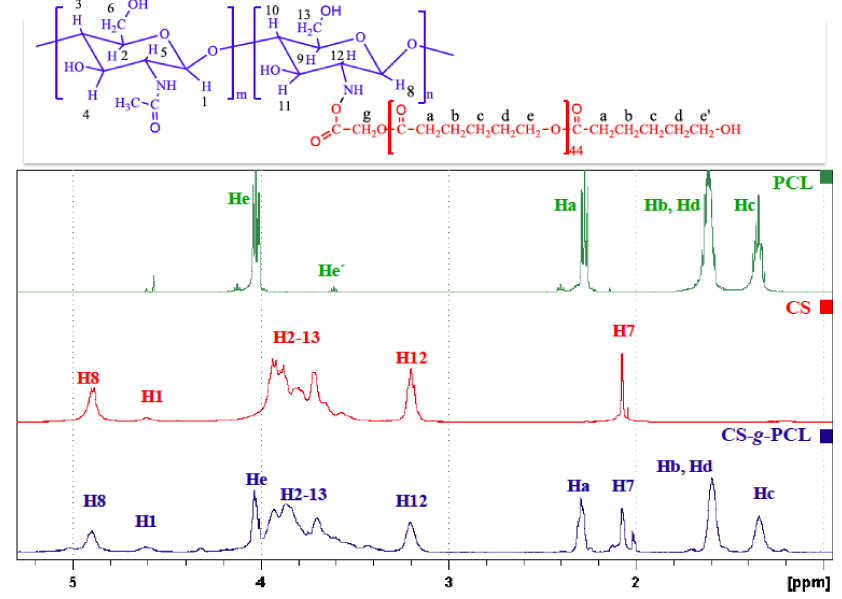
Figure 2. 1 H NMR CS, PCL and the synthesized graft copolymer CS- g